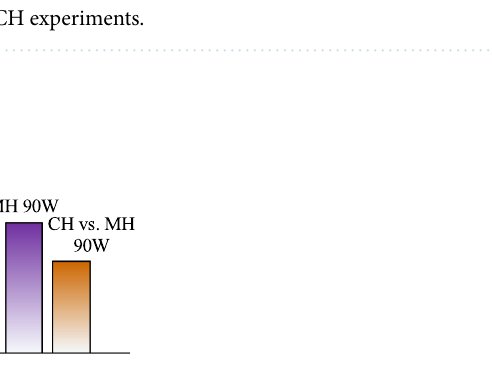
Figure 10. Comparison of the energy utilization efficiency under MH and